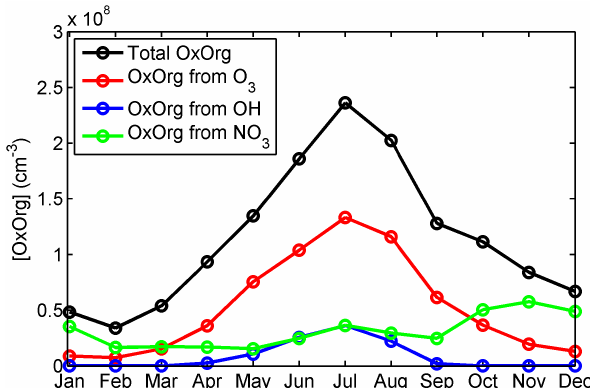
Figure 9. Monthly medians of the proxy for the oxidation products of monoterpenes (OxOrg). The black line shows the total concentra- tion of monoterpene oxidation products, the red line the oxidation products of monoterpenes from the oxidation by O 3 , the blue line the oxidation products of monoterpenes from the oxidation by OH and the green line the oxidation products of monoterpenes from the oxidation by NO 3